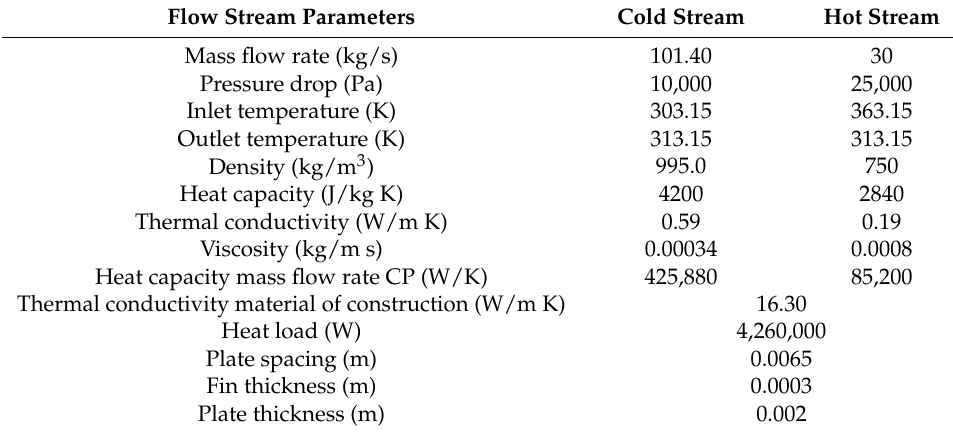
Table 6. Operating data and physical properties for the case